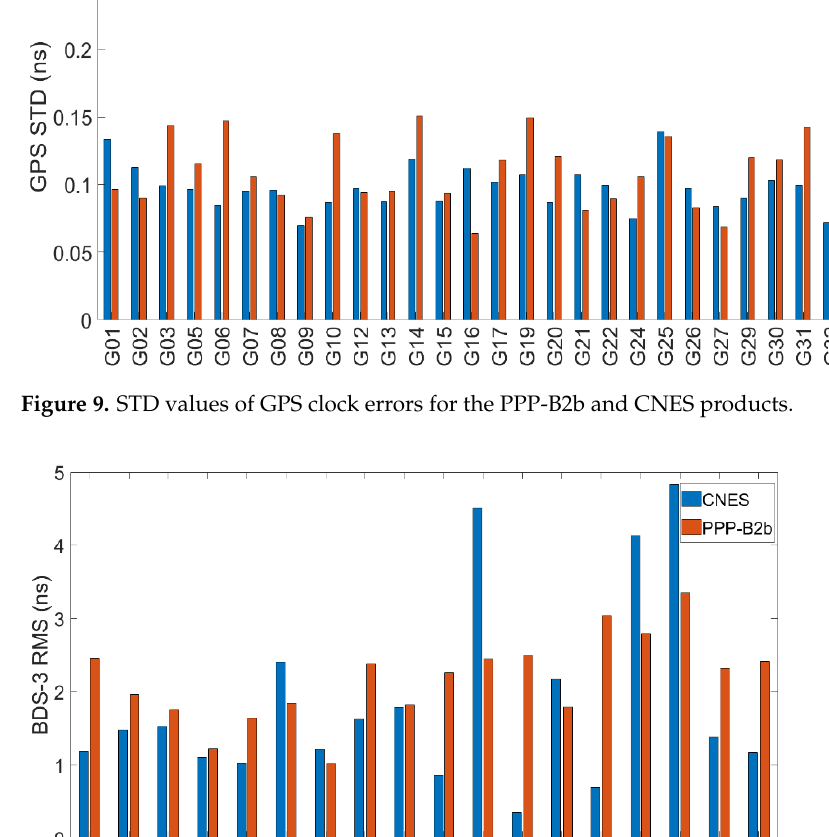
Figure 11. RMS values of GPS clock errors for the PPP-B2b and CNES products. The average STD and RMS of the CNES and PPP-B2b orbit and clock offsets are given in Table 1. According to the statistics, the accuracy of the PPP-B2b corrections of the radial